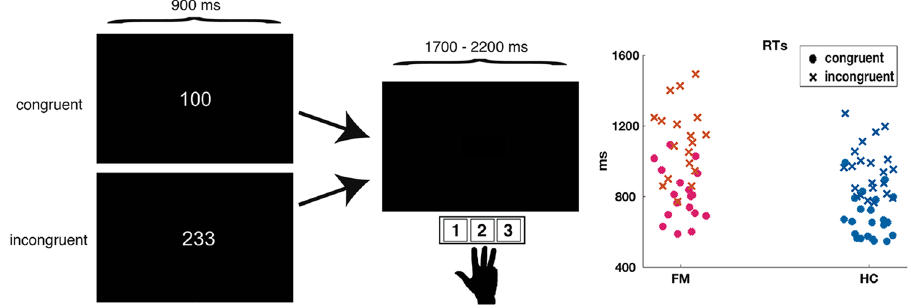
Figure 1. Task design and scatter plot of mean reaction times for each subject in each